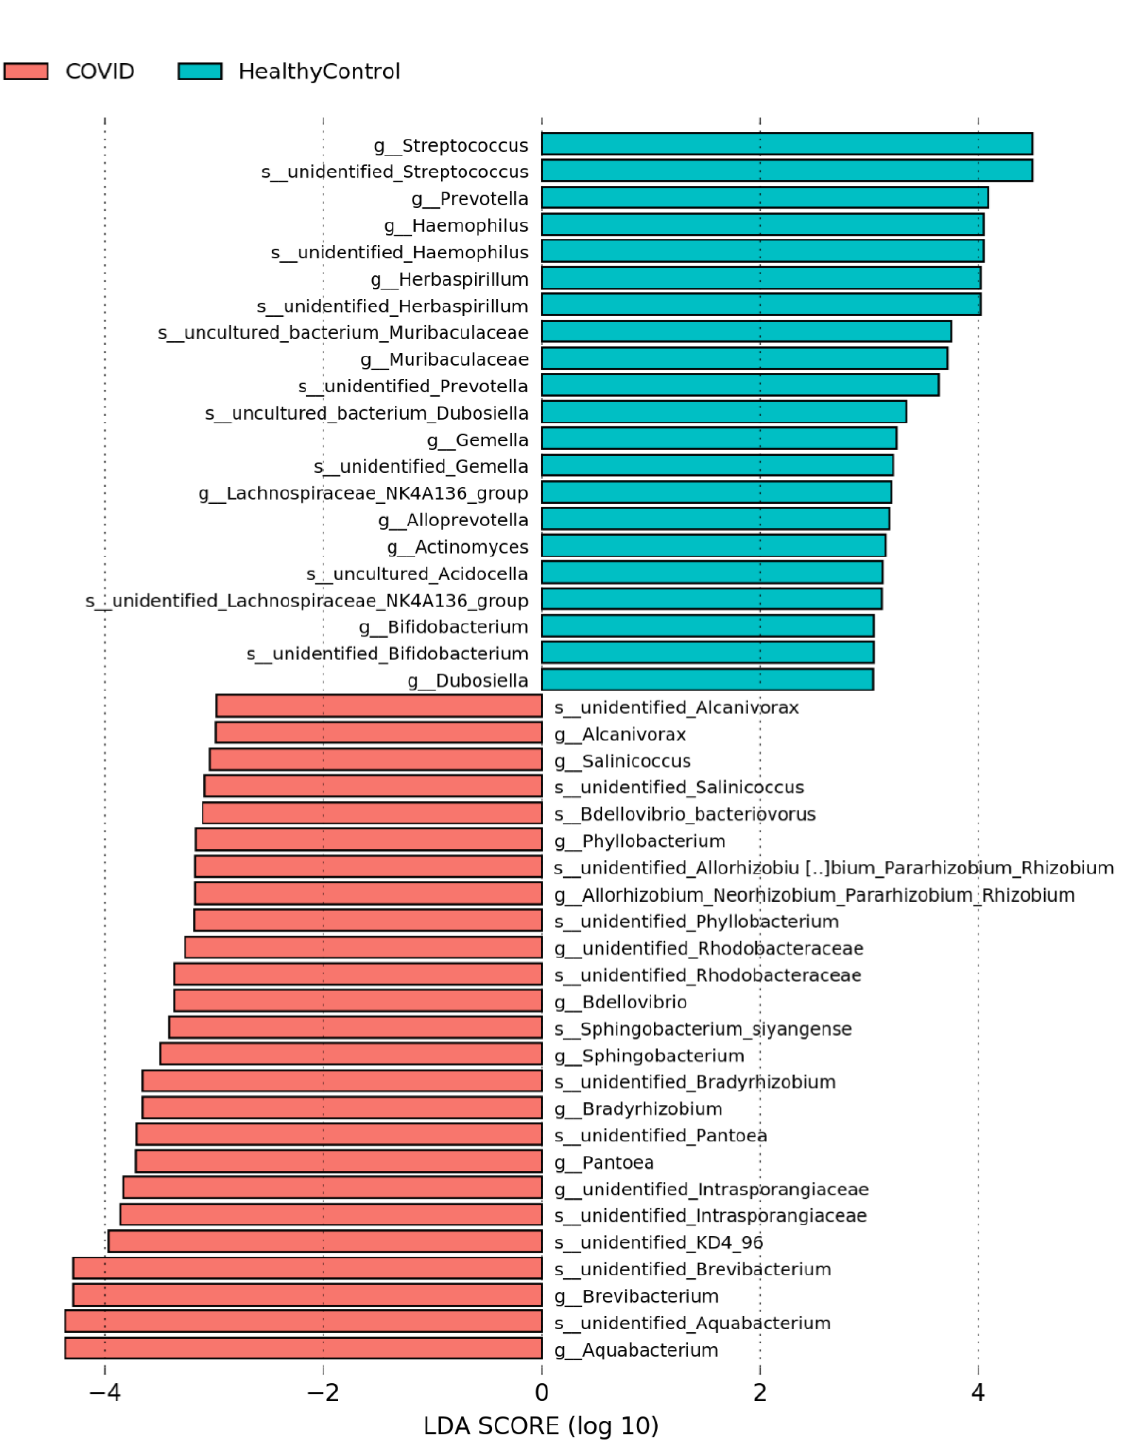
Bacteroidota . ( F ) The Firmicutes:Bacteroidetes (F:B) ratio indicates a significant increase in dysbiosis of the dominant phyla. Data are presented as mean ± S.E.M. Each dot represents a sample in the cohorts.